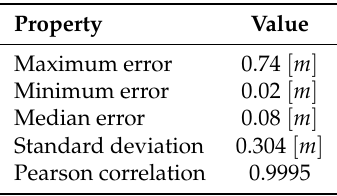
Figure 4. Outcome of calibration in the study reach. ( a ) Correlation plot between validation data and simulated WSE. ( b ) Manning number distribution obtained from calibration. Table 1. Statistics regarding the calibration of the